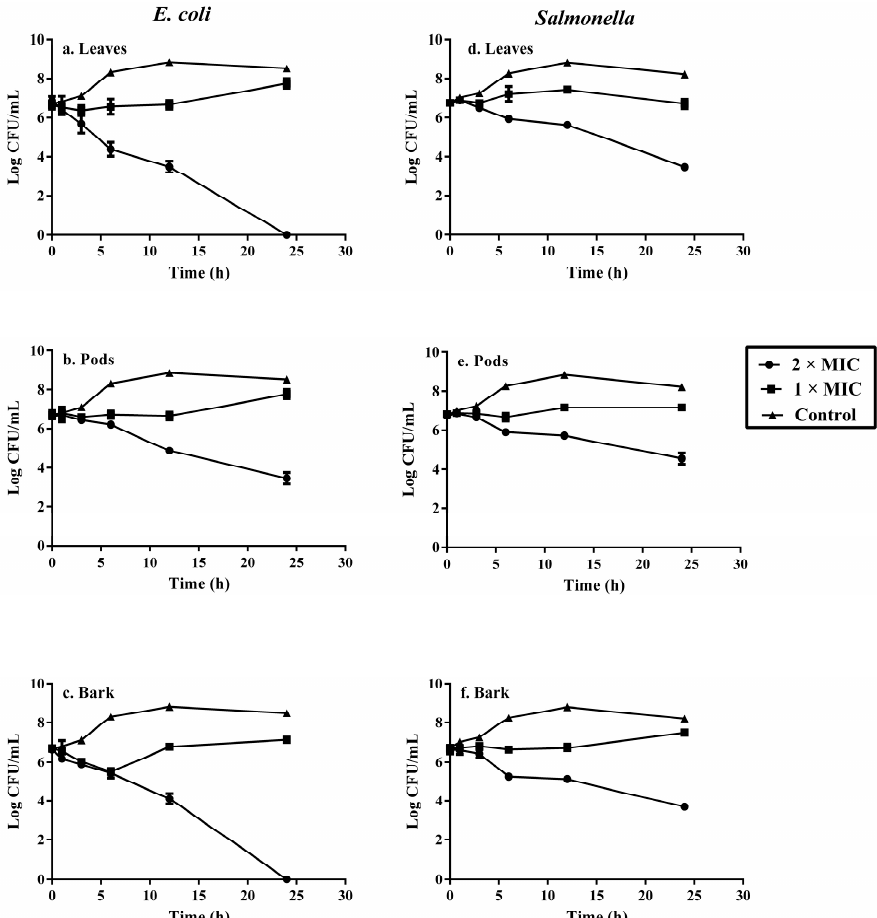
Figure 2. Effects of acacia leaves, pods and bark extracts on the viability of tested E. coli ( a – c ) and Salmonella typhimurium ( d – f ).